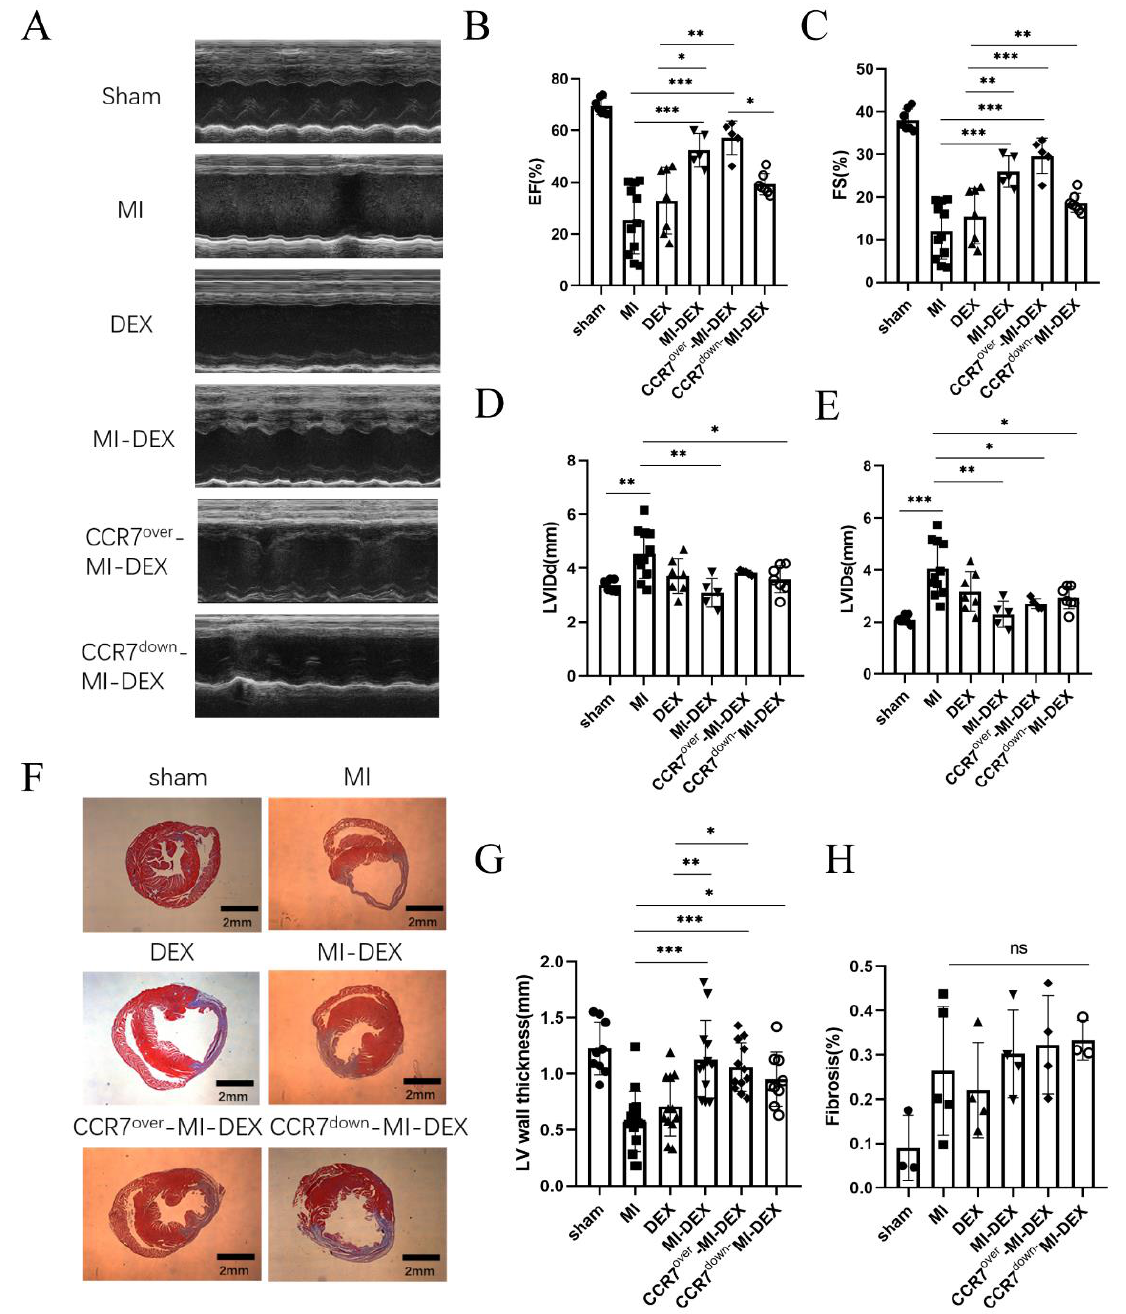
Figure 3. Enhancing MI-DEXs’ migration improved cardiac function after MI. Images of MI-model mice analyzed with echocardiography in different groups ( A ). Analysis of left ventricular ejection fraction (LVEF) in different groups ( B ). Analysis of left ventricular fraction shortening (LVFS) ( C ). Analysis of left ventricular end-diastolic diameter (LVIDd) ( D ). © Analysis of left ventricular end- systolic diameter (LVID©) ( E ). n = 5–10. Representative images analyzed by Masson’s trichrome staining in different groups ( F ). Infarct thickness (mm) in different groups ( G ). For each section, three measurements of different parts of the infarct area were taken for analysis. Analysis of fibrosis (%) in different groups ( H ). n = 3–5, * p < 0.05, ** p < 0.01, *** p < 0.001.